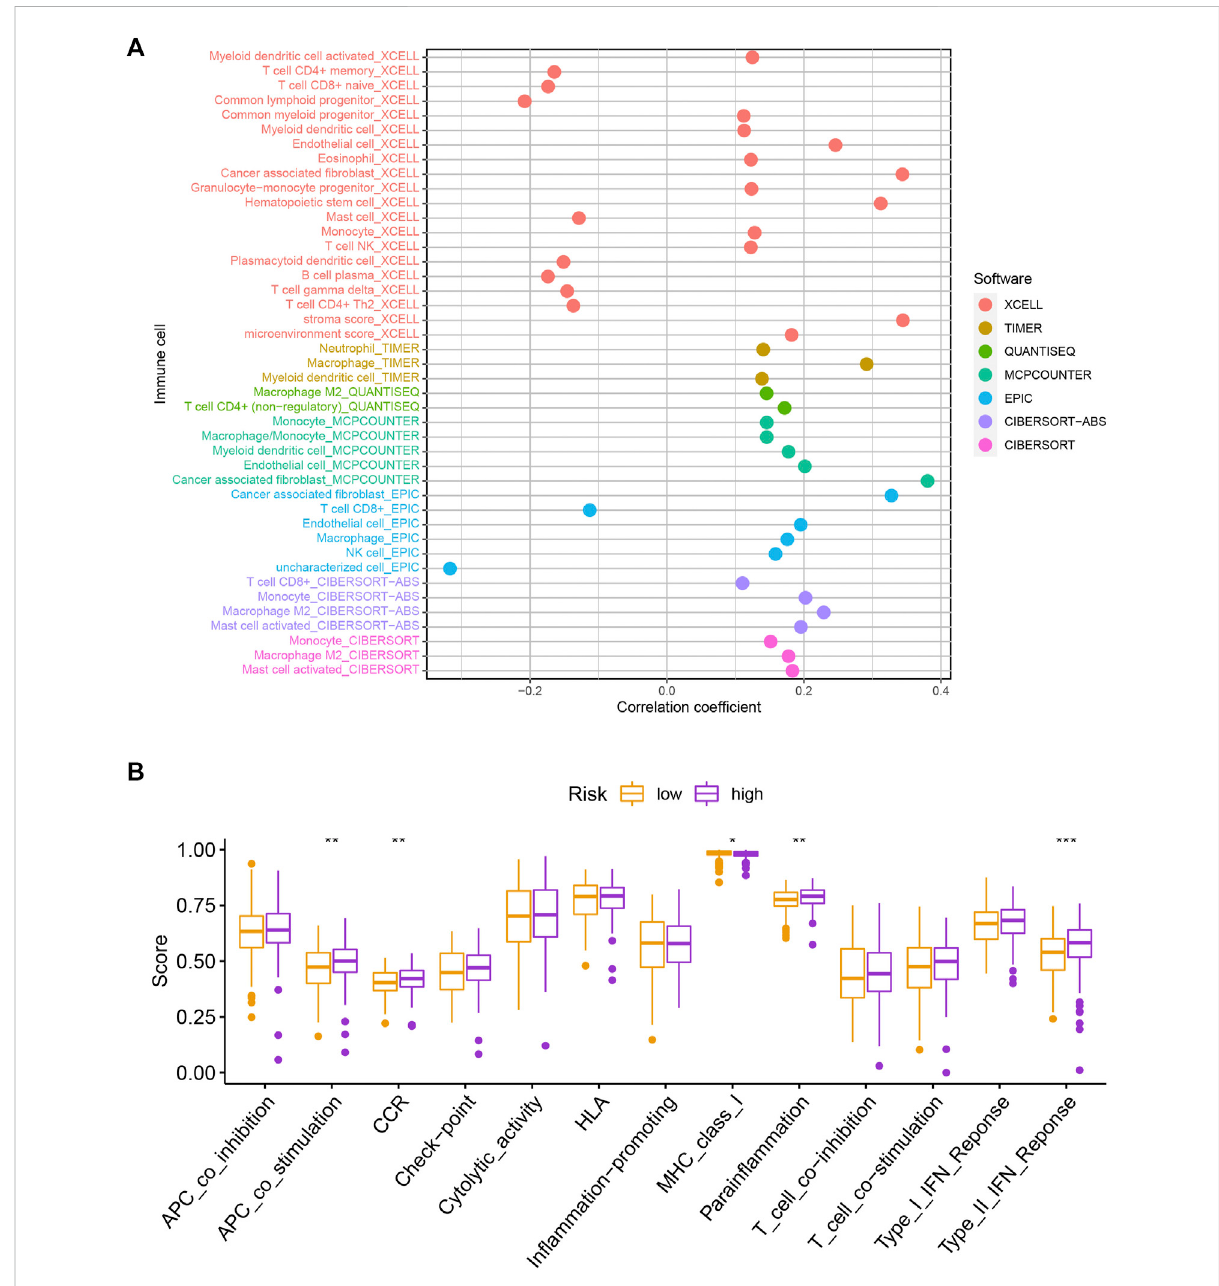
FIGURE 6 Assessment of the immune landscape. (A) Changes in immune cell in fi ltration that are identi fi ed by the MRlncRNA-based risk model are linked to an increased chance of developing GC. (B) Several immune functions were statistically different between the two